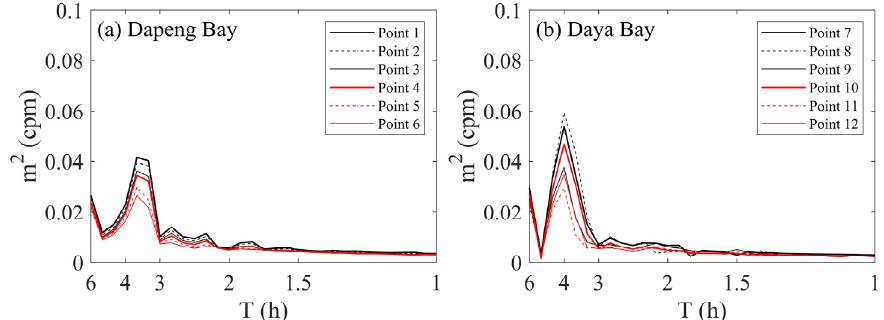
Figure 6. Positions of ( a ) the six locations in Dapeng Bay and ( b ) the six locations in Daya Bay (marked by numbers in red) off Shenzhen, Guangdong Province of China.